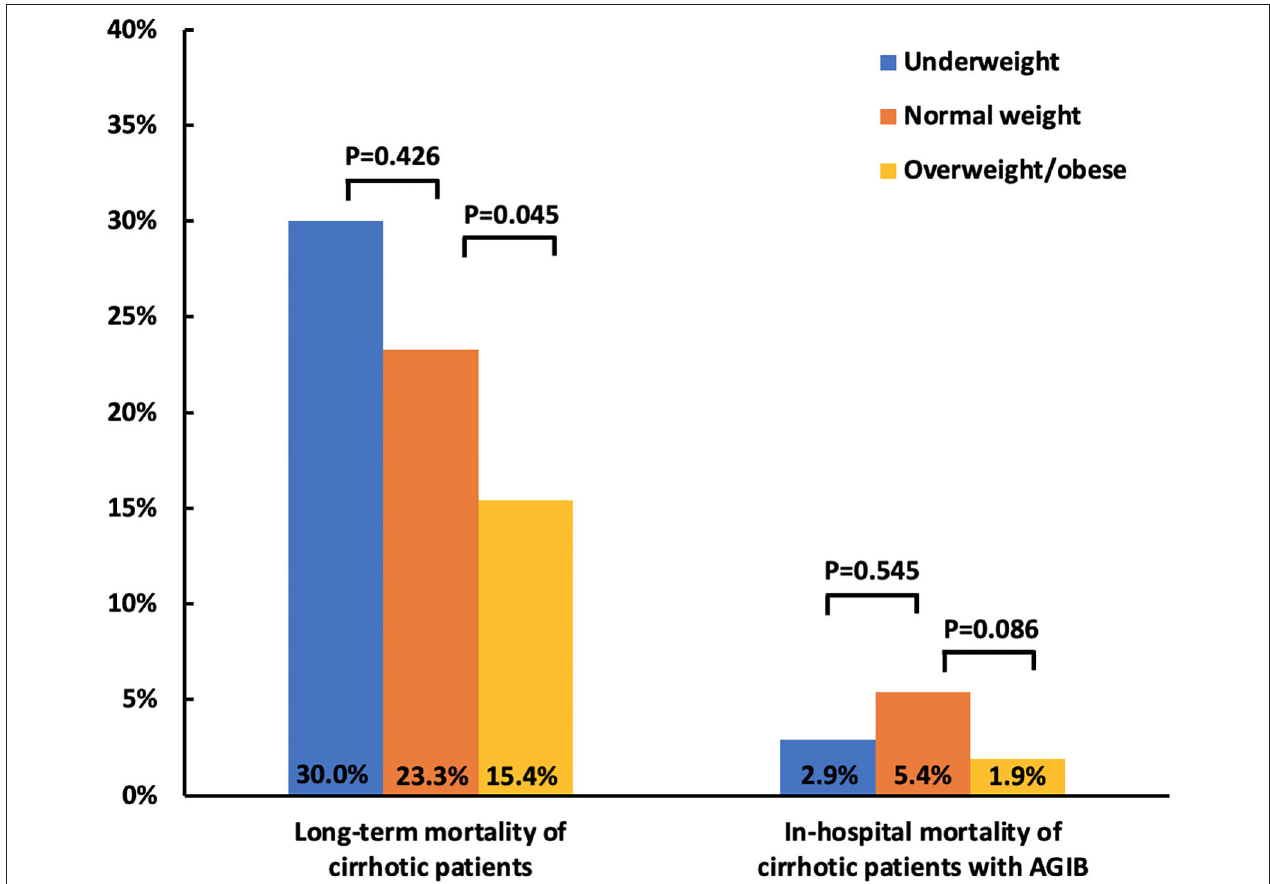
FIGURE 1 | Bar charts showing the association of BMI with mortality in patients with cirrhosis. BMI, body mass index; AGIB, acute gastrointestinal bleeding.